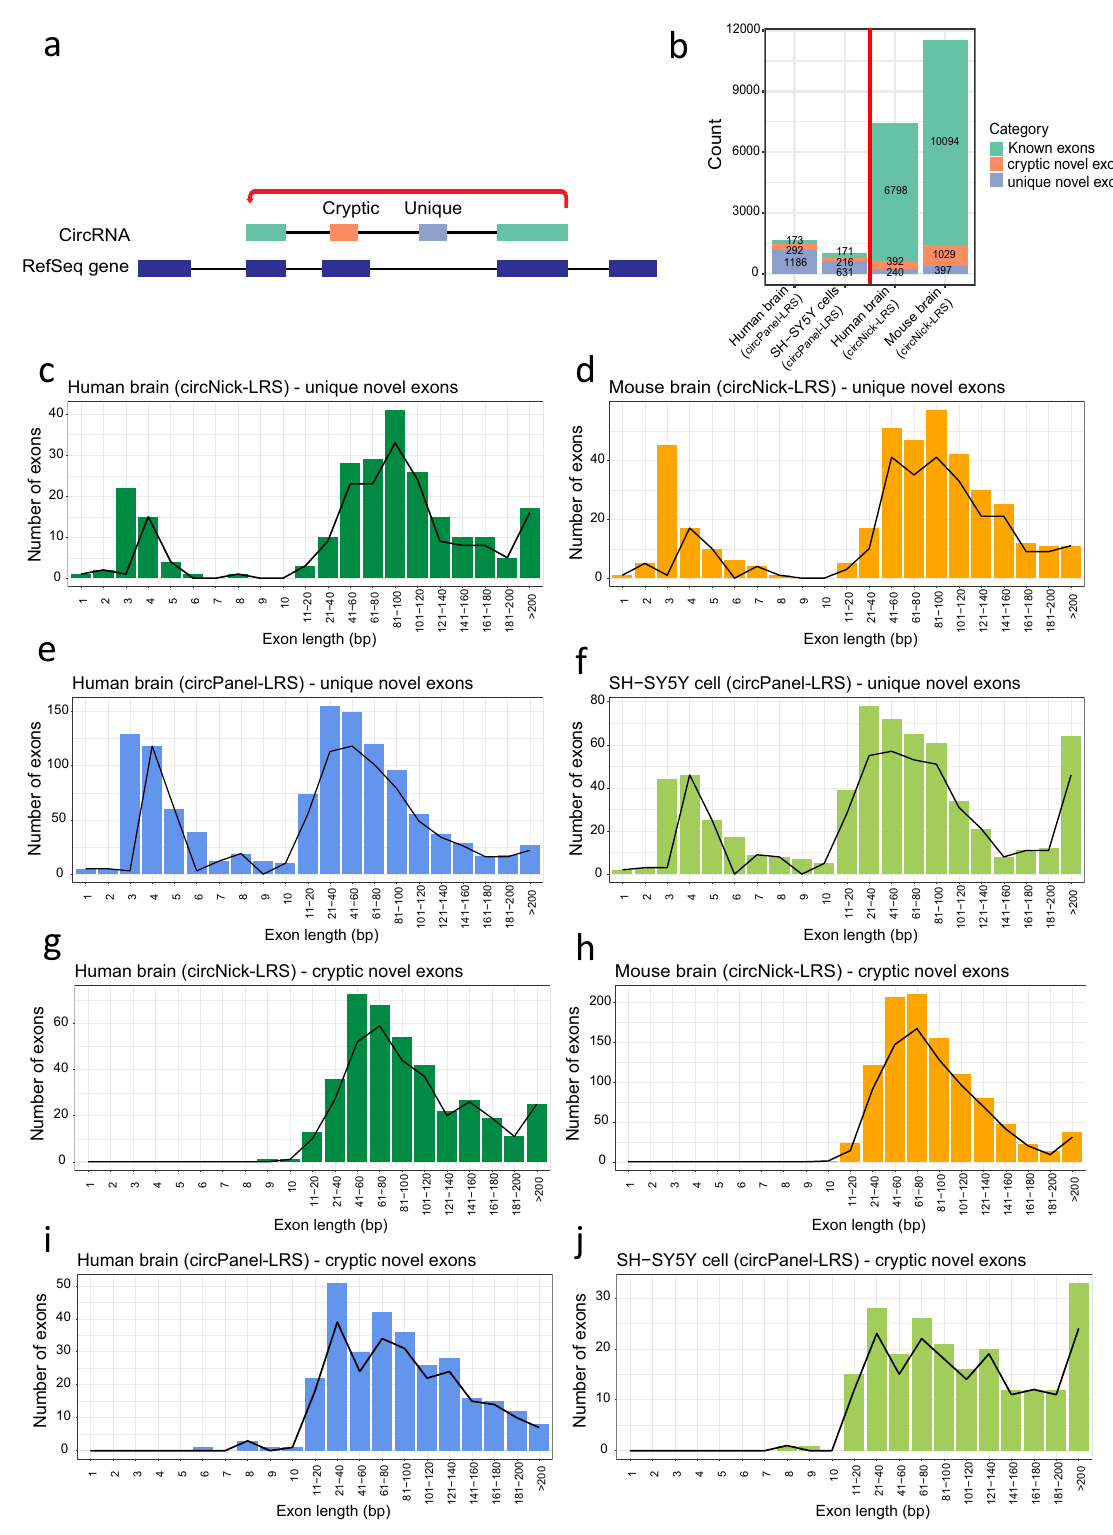
Fig. 5 CircRNAs contain unique and cryptic novel exons. a Schematic representation of circRNAs with novel exons produced from either cryptic spliced exons (peach) or novel exons (blue gray). The arrow indicates the back-splicing event. b Number of known exons, cryptic novel exons, and unique novel exons in circRNAs across all datasets in this study. Only exons covered by at least fi ve long-reads across the back-splice junction are included. c – j Distribution of exon length of the unique novel ( c – f ) and cryptic novel ( g – j ) exons in all four datasets made by either circNick-LRS ( c , d , g , and h ) or circPanel-LRS ( e , f , i , and j